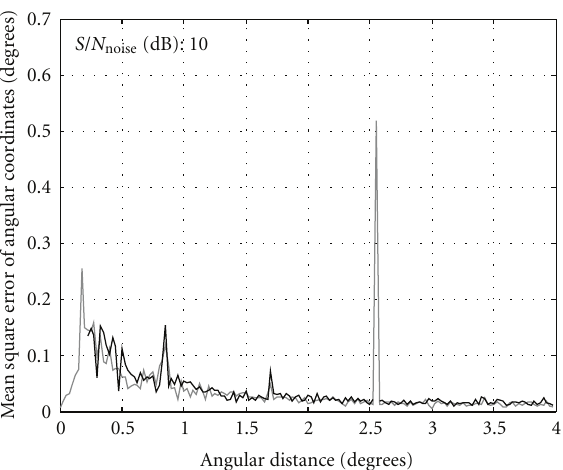
Figure 13: Histogram of mean square error of polar coordinates evaluated by using the TLS ESPRIT method at S/N noise = 10dB, in absence of an external noise signal and a constant repetition time of radar pulses, T p = 4 ms, v = 1000m/s.